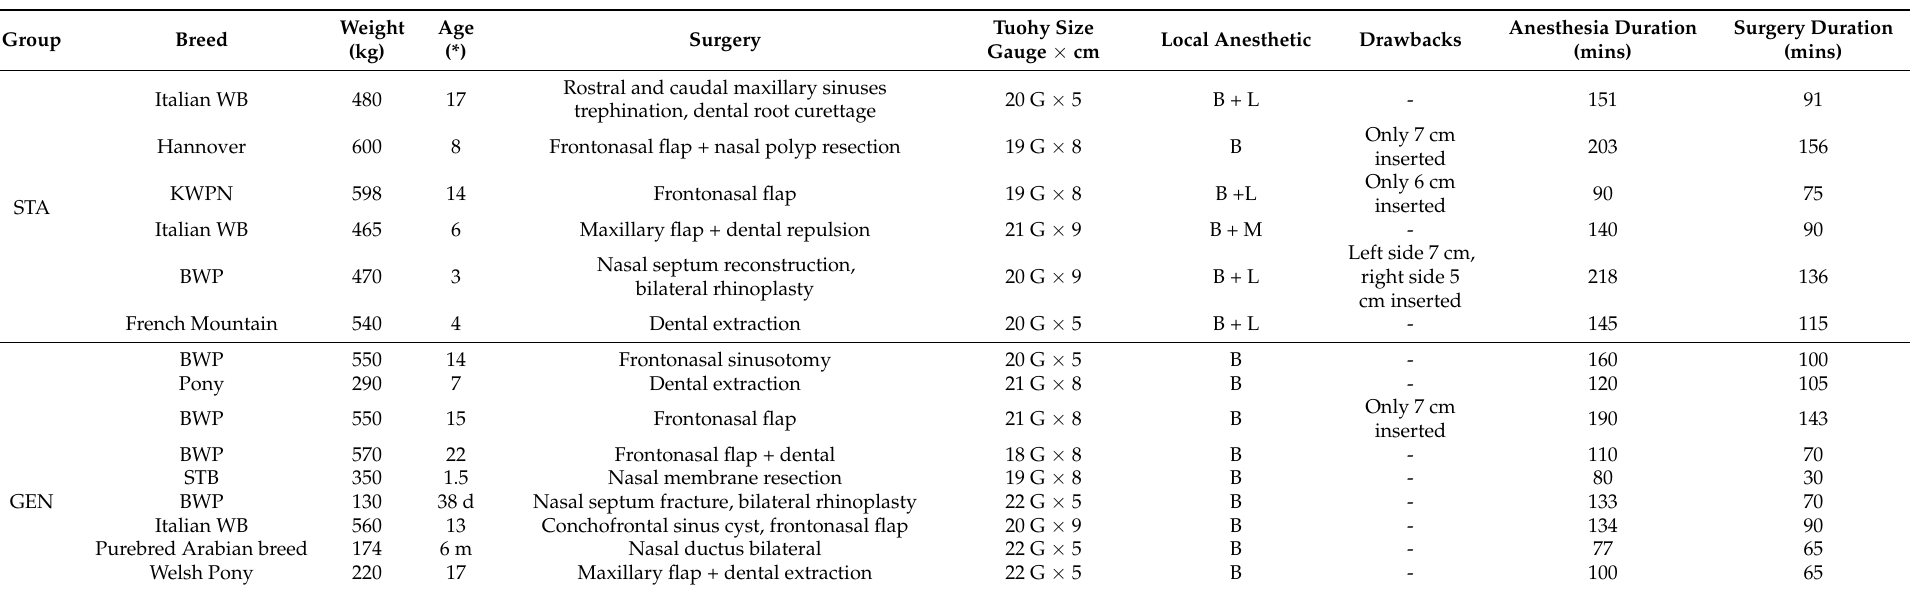
Table 1. Description of horses undergoing orofacial surgery which received a retrograde maxillary nerve block. STA = standing surgery; GEN = general